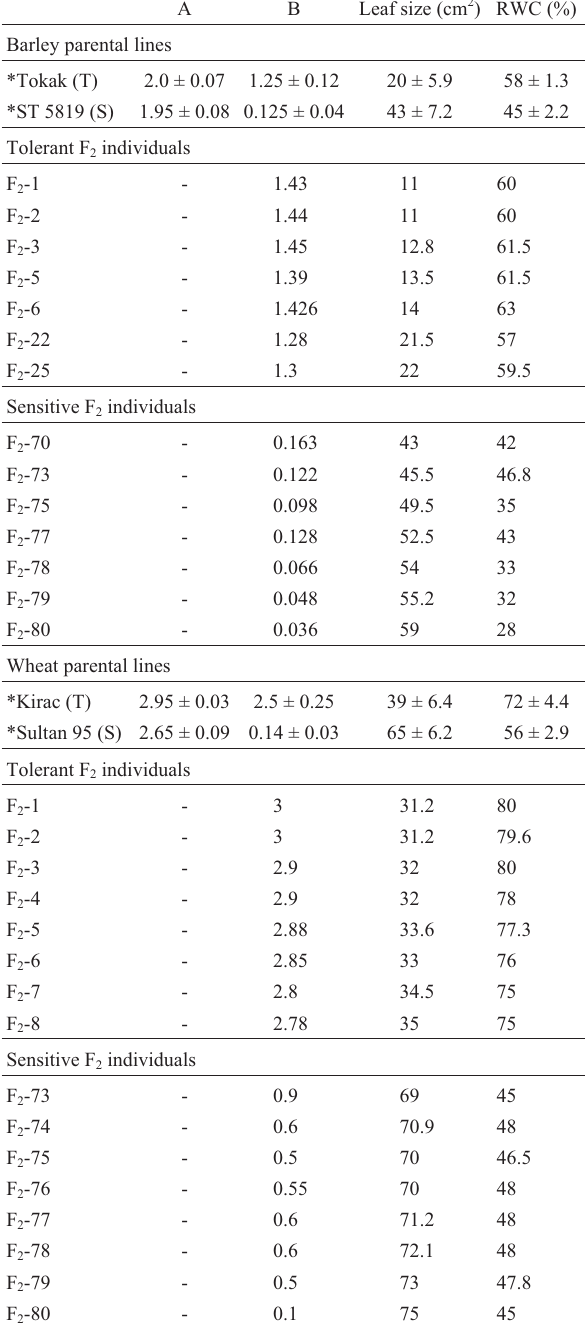
Table1 -Morphologicalandphysiologicaldatausedformakingthewater stress tolerant and sensitive barley and wheat bulks in both parental lines and their selected F 2 individuals. Measurements of leaf size and chlorophyll content after PQ treatment were conducted on the 2 nd top leaf taken from the plants during the preflowering stage. Leaf extracts were analysed for determination of chlorophyll content after treating leaves with 100 µ M PQ solution under a light intensity of 12000 lux for 24 h. Application of water stress and measurement of RWC were according to Altinkut et al. (2001). *Values presented for parental genotypes were averages of data taken from 20 parental